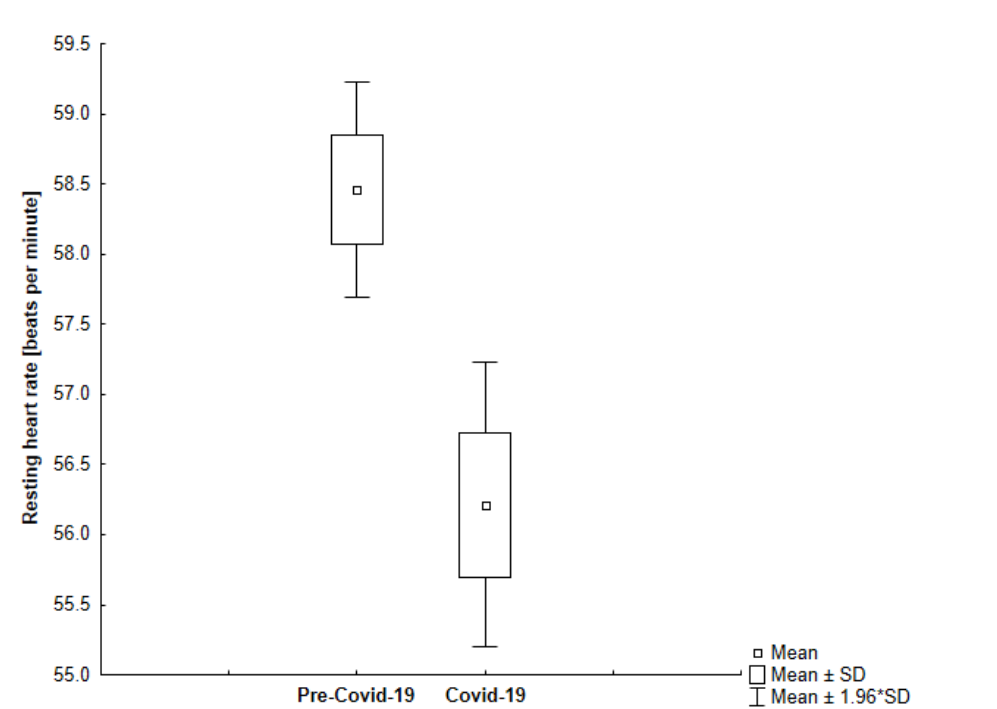
Figure 8. The comparison of the average resting heart rate in the analyzed periods among older participants ( p < 0.001).